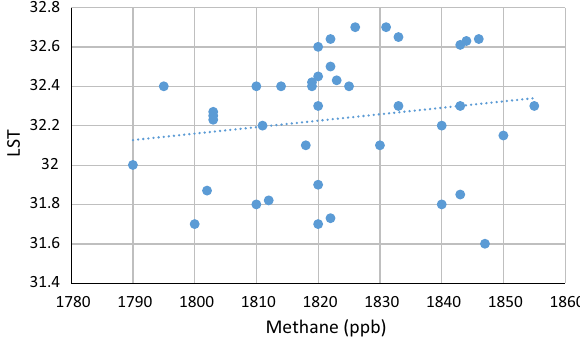
Fig. 11 Relationship between methane and LST in summer